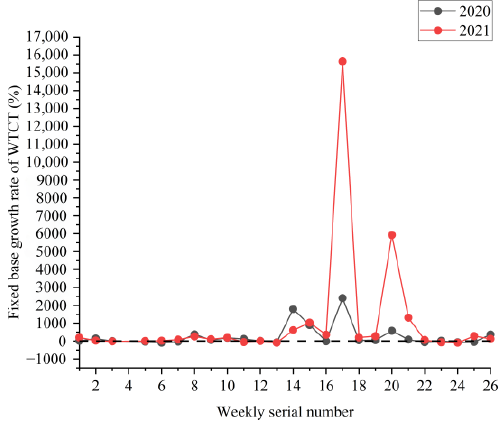
Figure 7. Fixed base growth rate of WTCT. Table 3. The descriptive statistical results of the NPTHN service level assessment parameters. Parameter Mean Value Standard Deviation